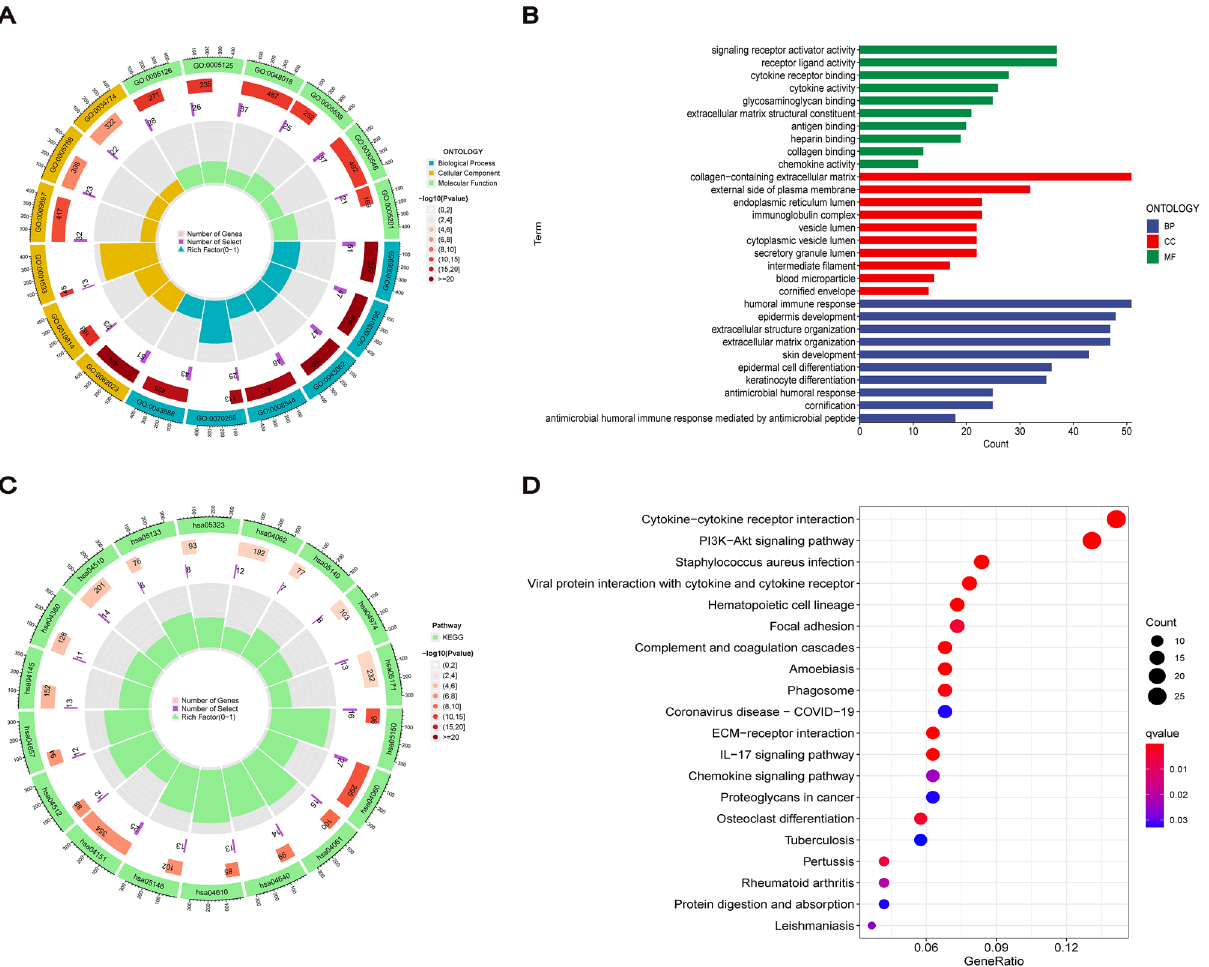
Figure 8. Functional enrichment of cuproptosis-related lncRNAs with risk signature. ( A ) Circos plot for GO enrichment. ( B ) Barplot for GO enrichment. ( C ) Circos plot for KEGG pathways. ( D ) Bubble graph for KEGG